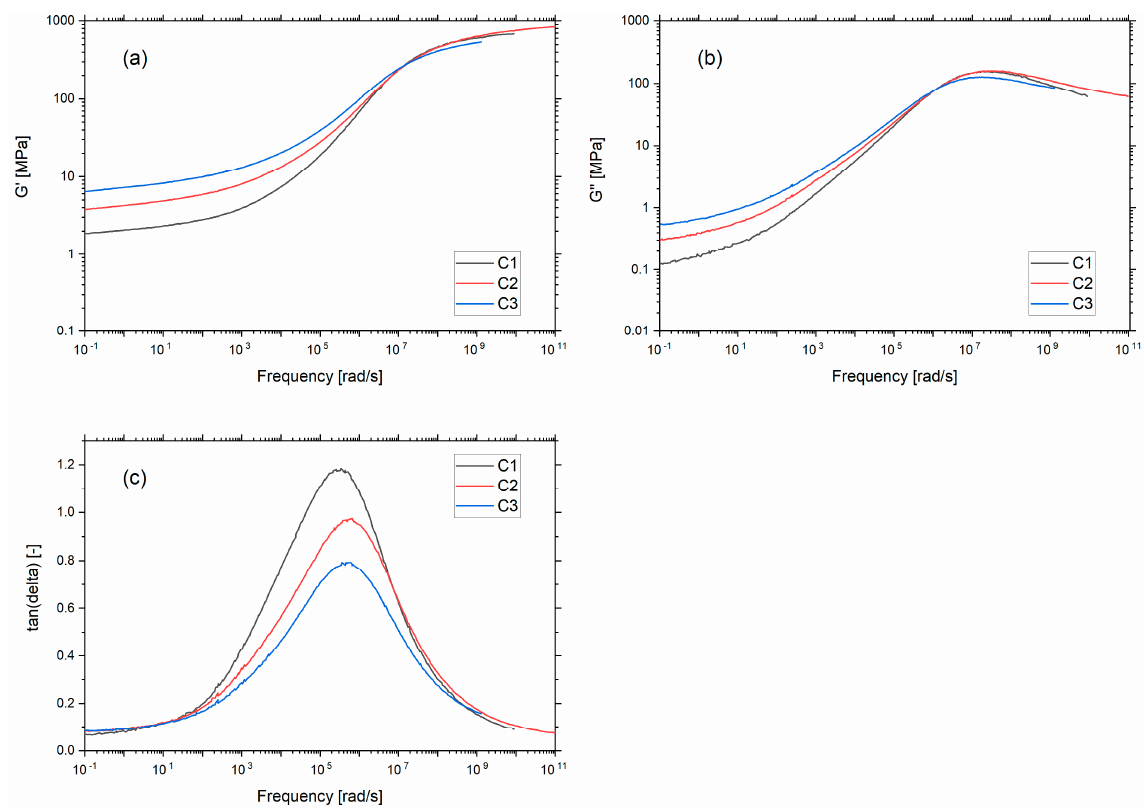
Figure 4. ( a ) Storage modulus ( b ) loss modulus and ( c ) tan δ versus angular frequency at 21 °C.